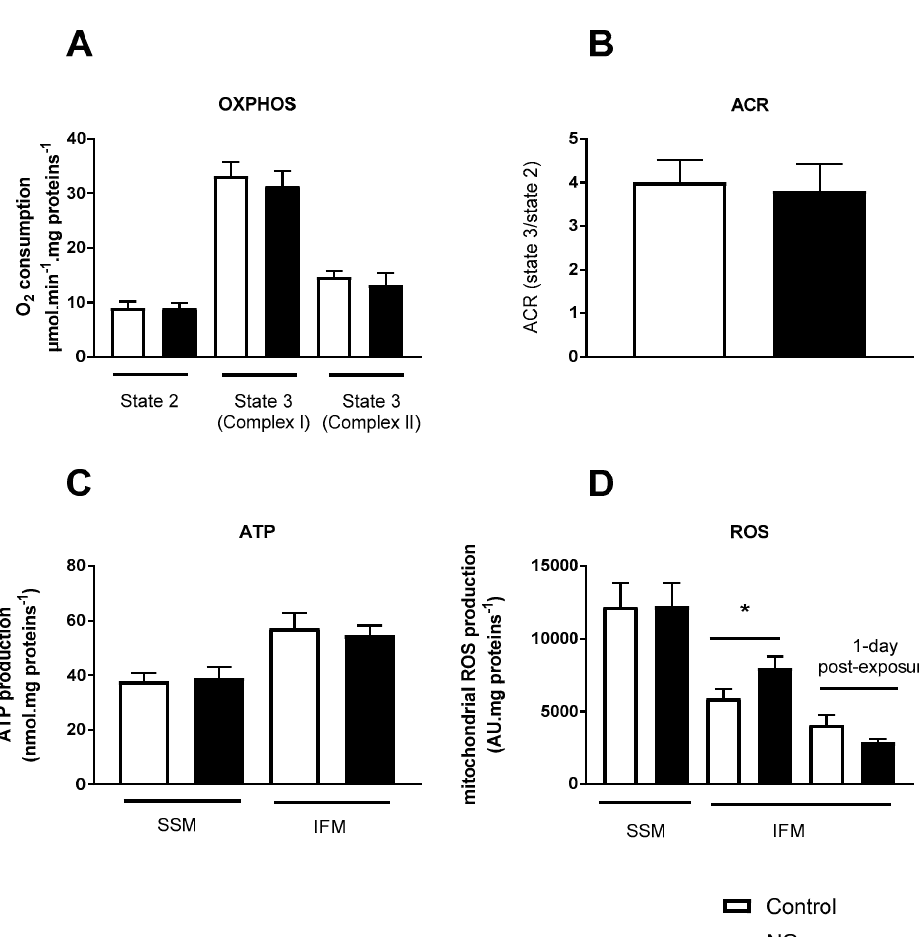
Figure 4. Cardiac mitochondrial function and ROS production after acute NO 2 exposure. ( A ) Mitochondrial OXPHOS evaluated by O 2 oxygen consumption assessment in cardiac permeabilized fibers. State 2 respiration with complex I-linked substrates (Glutamate / Malate); State 3 respiration with complex I-linked substrates (Glutamate / Malate); State 3 respiration with complex II-linked substrates (Succinate); ( B ) Acceptor control ratio (ACR) with complex I-linked substrates ( C ) adenosine triphosphate (ATP; nmol / mg proteins) and ( D ) reactive oxygen species (ROS) productions (A.U / mg proteins) were measured from freshly isolated subsarcolemmal (SSM) and interfibrillar (IFM), 1 h or 1-day post-exposure, when specified, after acute NO 2 or air (control) exposure. * p < 0.05.